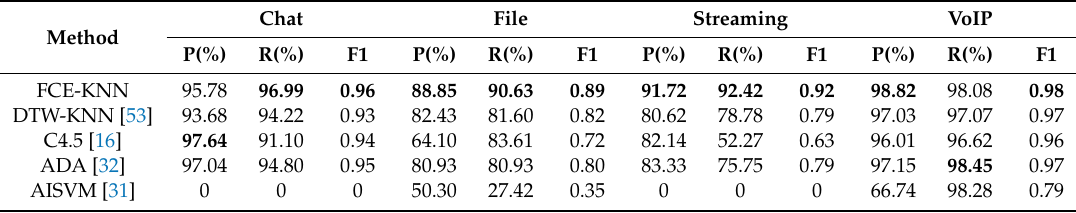
Table 9. Performance comparison between FCE-KNN and other algorithms for identifying content type of encrypted network